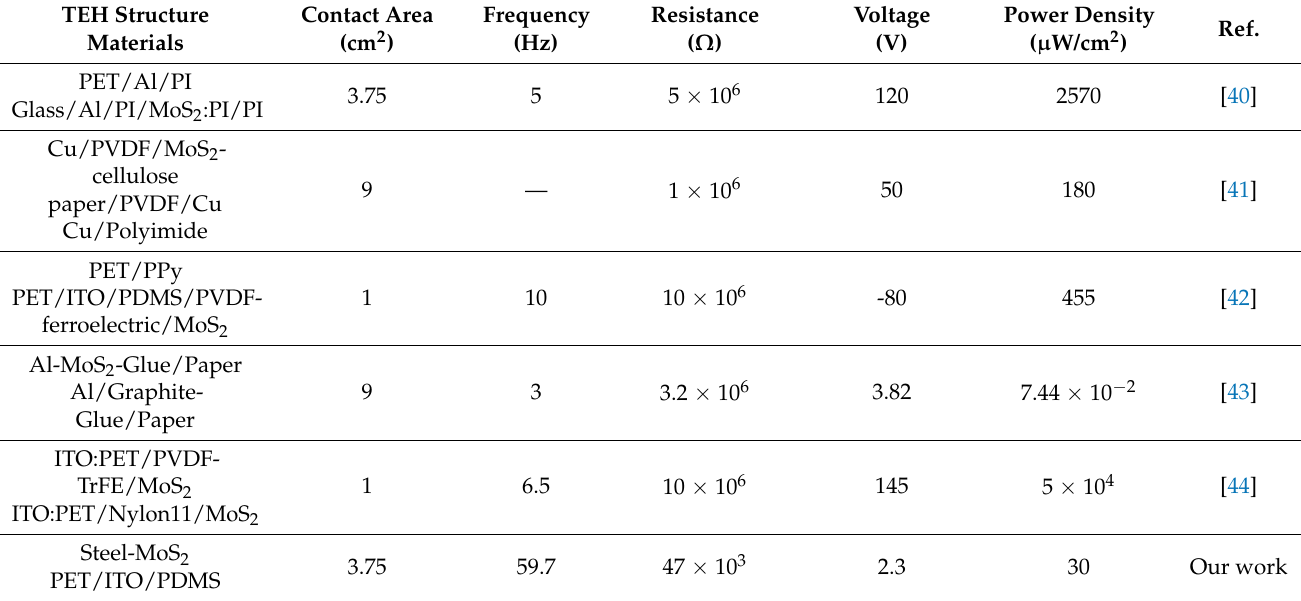
Table 1. Comparison of the main parameters of different TEH devices that contain MoS 2